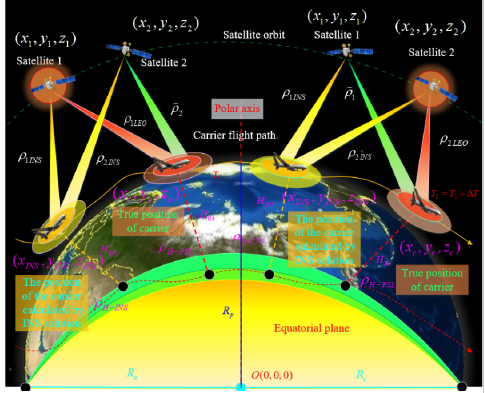
Figure 3. INS + LEO2 alternate switching + altimeter integrated navigation algorithm principle